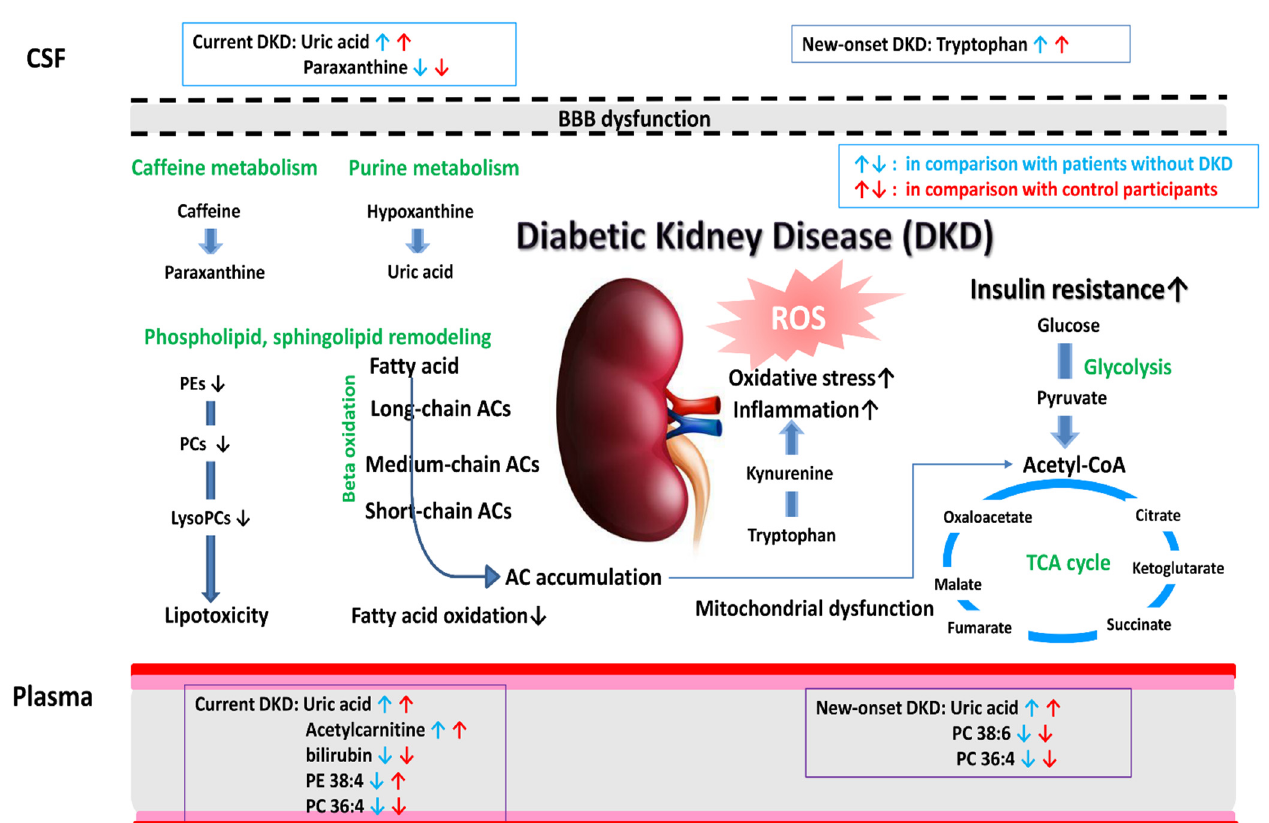
Figure 5. Schematic representation of the significant metabolite alterations in diabetic kidney dis- ease.